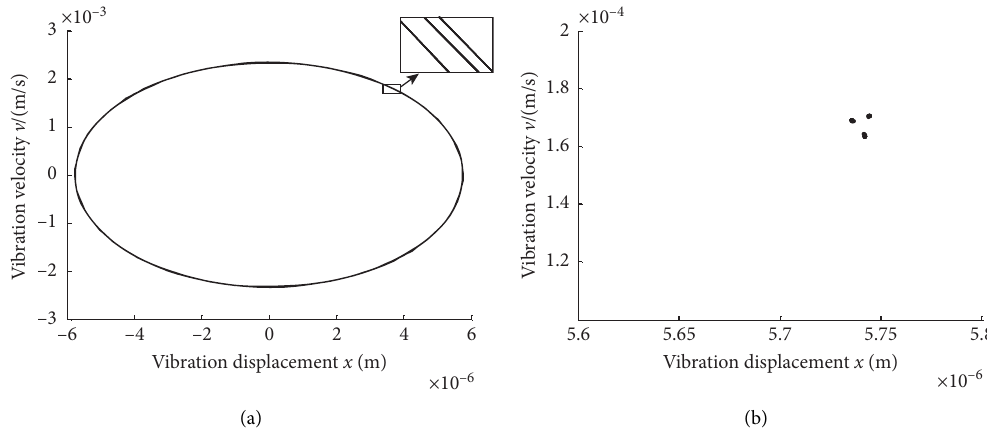
Figure 10: F � 6 . 15 × 10 5 N , 3-time cycle movement. (a) Phase trajectory diagram. (b) Poincar´e section.